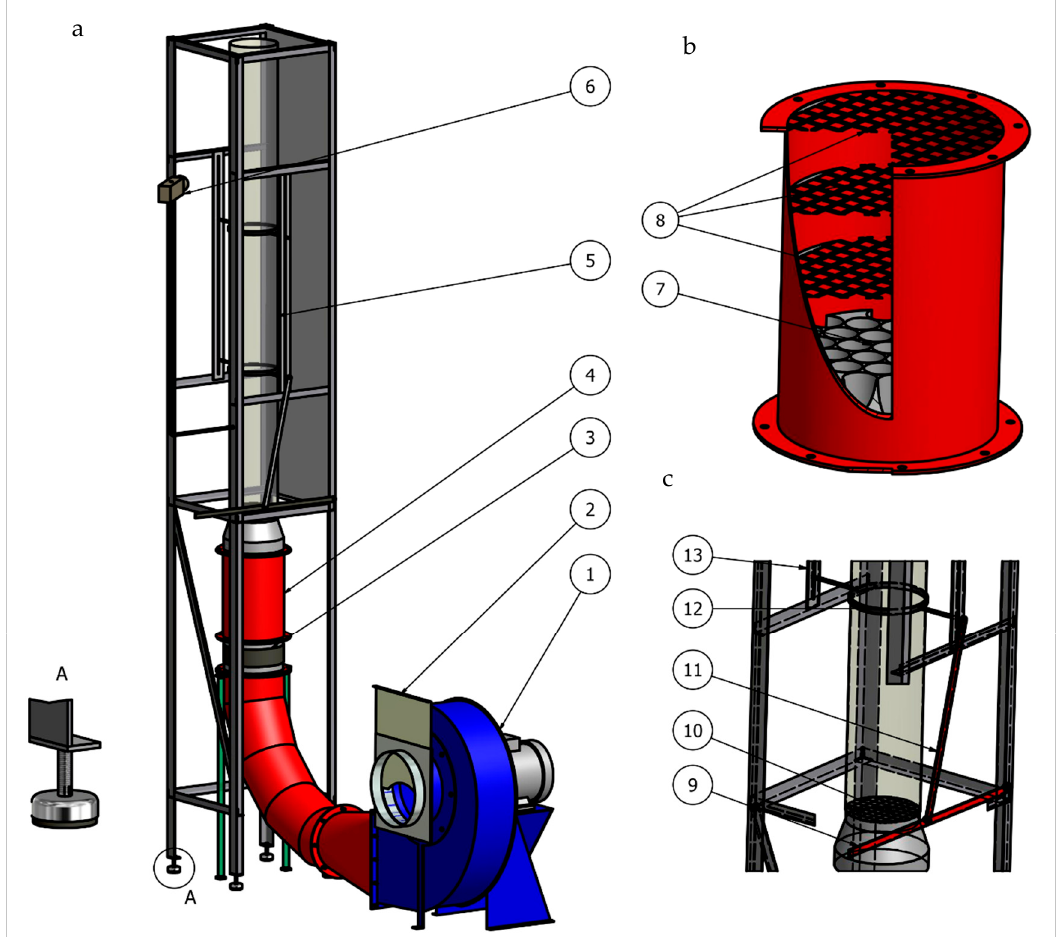
Figure 7. Concept drawing of the experimental setup for the measurement of the aerodynamic properties of plant material, showing ( a ) the general view, ( b ) the flow homogenization section, and ( c ) the particle introduction method. 1 = duct fan, 2 = throttle, 3 = amortizing spigot, 4 = homogenization section, 5 = acryl pipe, 6 = camera, 7 = honeycomb structure, 8 = sieve screens, 9 = lever, 10 = sieve, 11 = connector, 12 = holder, and 13 = guide bar [18]. Image provided with permission from Tomasz Reguła (source: own